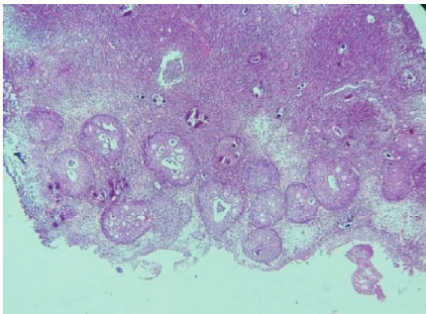
Figure 4: Giant cells phagocytizing eggs of viable bilharzia. He- matoxylin and eosin x 100 (image of Professor Dial, head of the pathological anatomy laboratory of HOGIP).